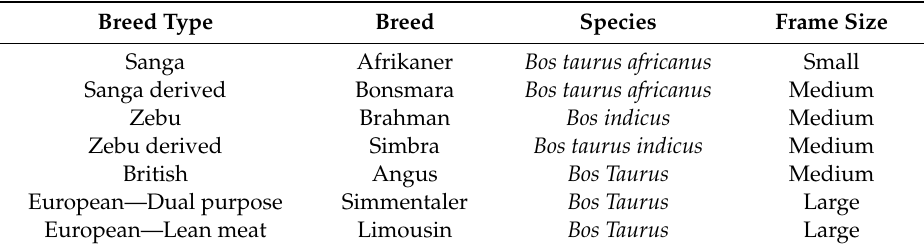
Table 1. Selected breed types and